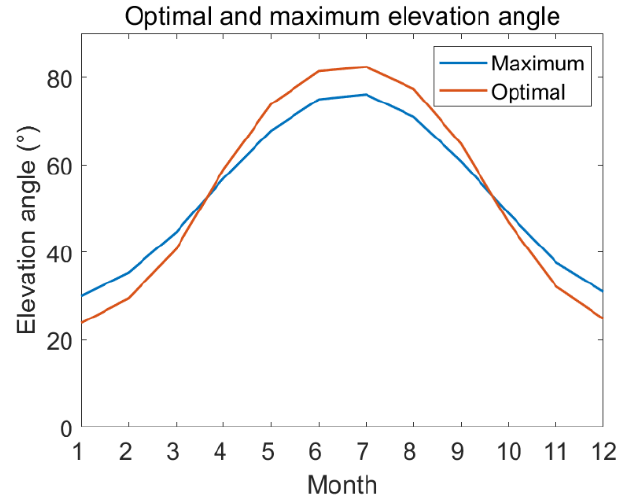
Figure 5. Variation of the solar azimuth angle on the first day of each month in 2019.